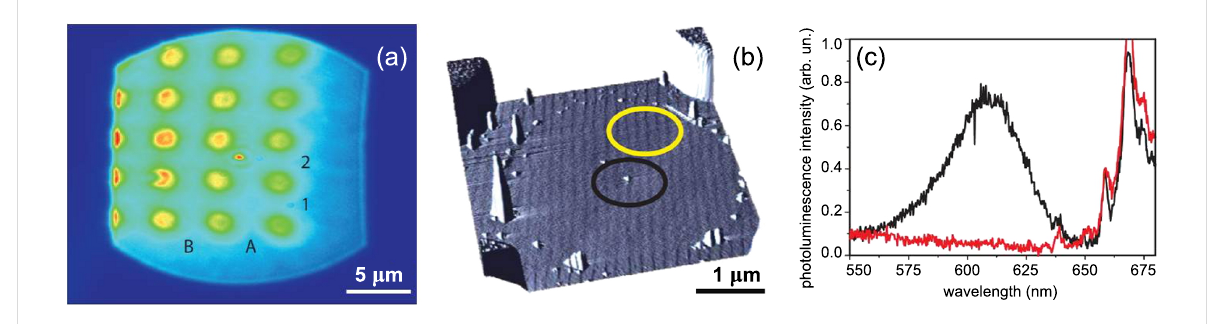
Figure 3: (a) A white-light image of several cells. The laser spot can be seen in cell A2; (b) An AFM image of cell B1. The black circle shows a single isolated QD, while the yellow circle indicates an area that has been cleared of QDs; (c) Photoluminescence spectrum from the areas of the cell high- lighted in (b) after excitation with the 442 nm line of a He:Cd laser. The 610 nm QD emission can be clearly seen in the black spectrum. The emission above 650 nm is due to chromium contamination in the sapphire